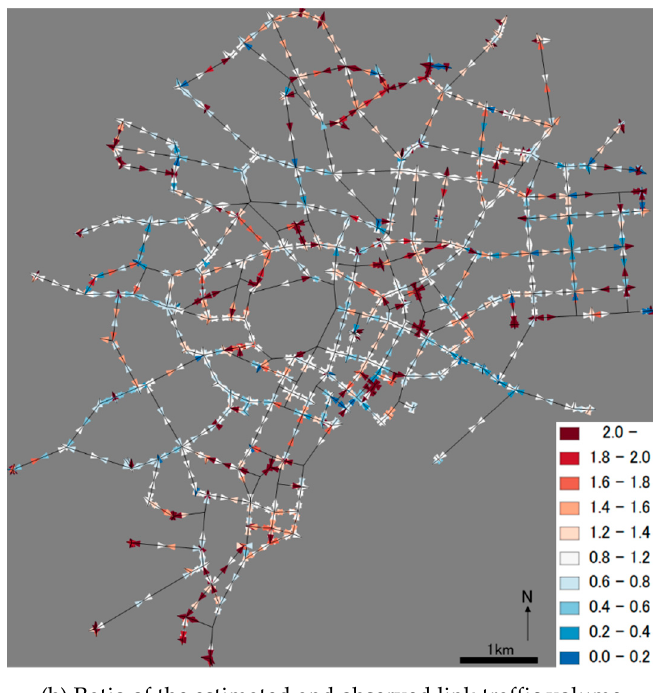
Figure 8. Distributions of the observed link traffic volume and the ratio of the estimated and observed link traffic volume of passenger cars.